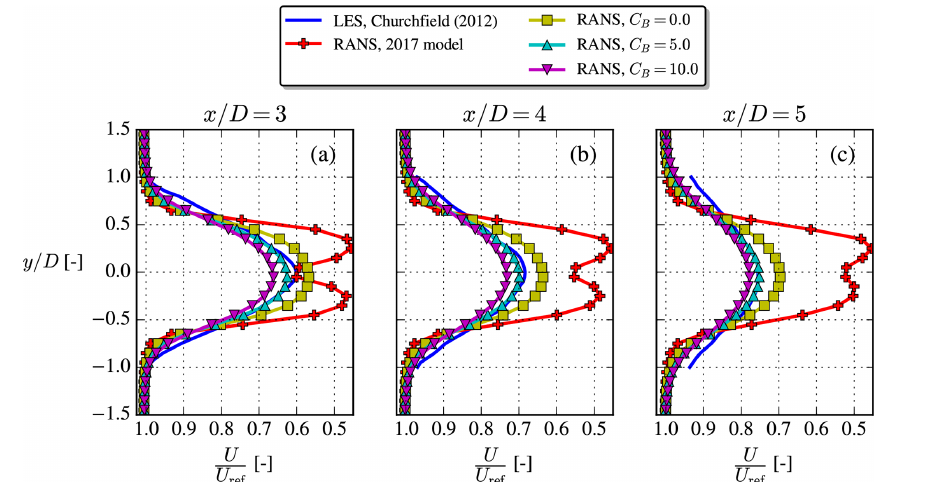
Figure 14. The unstable NREL5MW case, where LES results were digitized from Churchfield et al. (2012). Profiles extracted at z = z ref